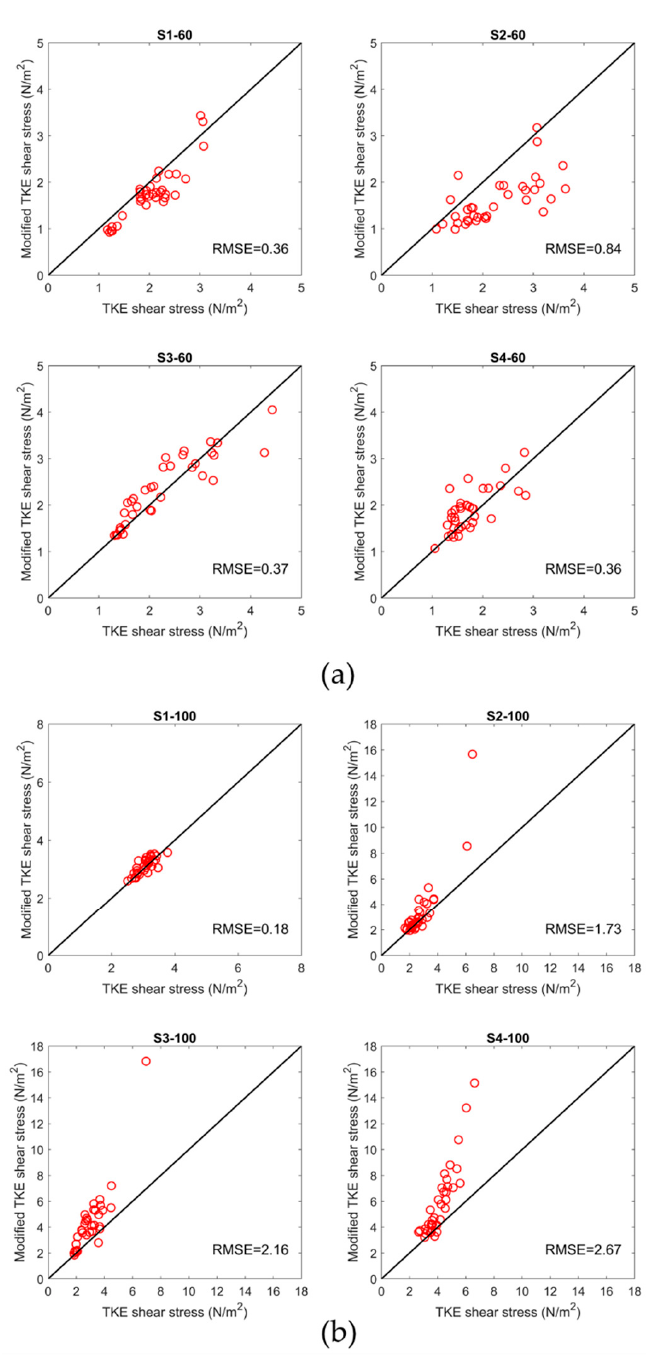
Figure 4. Near-bed shear stress estimated from the turbulent kinetic energy (TKE) method against the modified TKE method for all the measurement points at ( a ) 60 L/s flow rate, ( b ) 100 L/s flow rate. The unit of RMSE is N/m 2 .